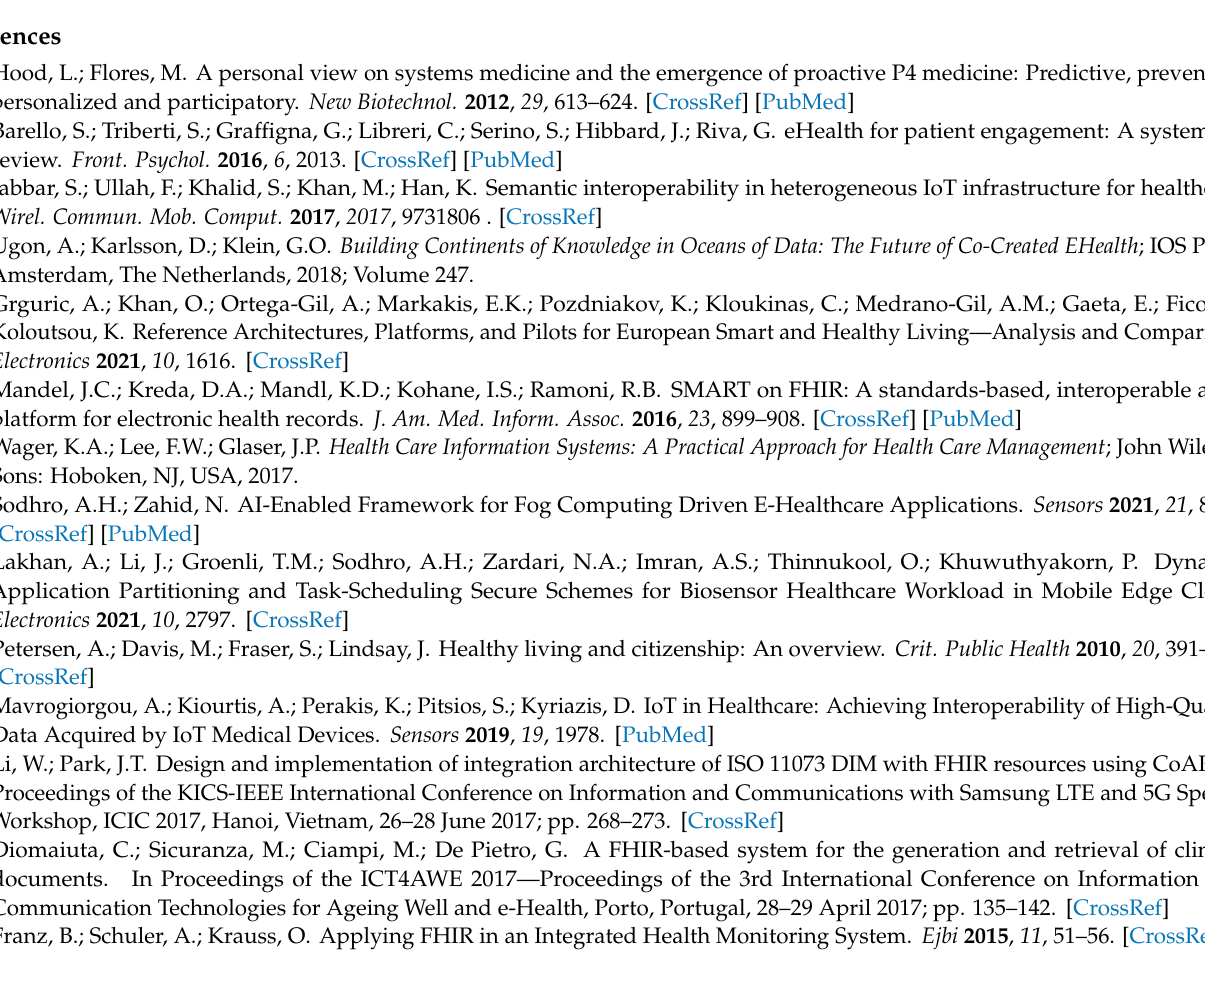
Figure A3. Sequence diagram of the interoperability services with FHIR and universAAL